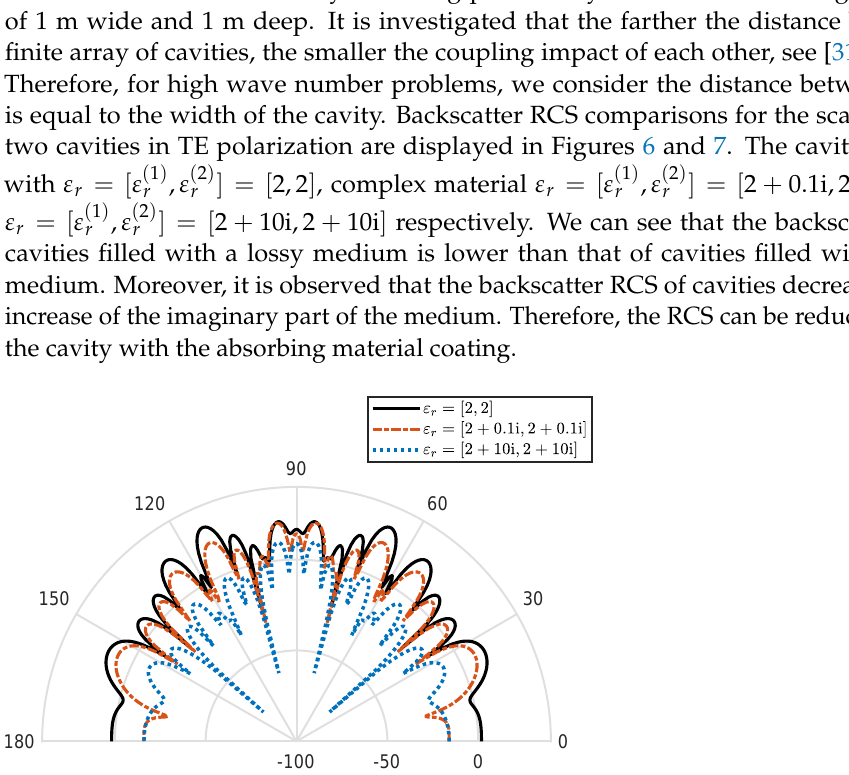
Figure 6. The backscatter RCS by two cavities in TE polarization with k 0 = 4 π m − 1 on 256 × 256 meshes for the media [ 2,2 ] , [ 2 + 0.1i,2 + 0.1i ] and [ 2 + 10i,2 + 10i ]